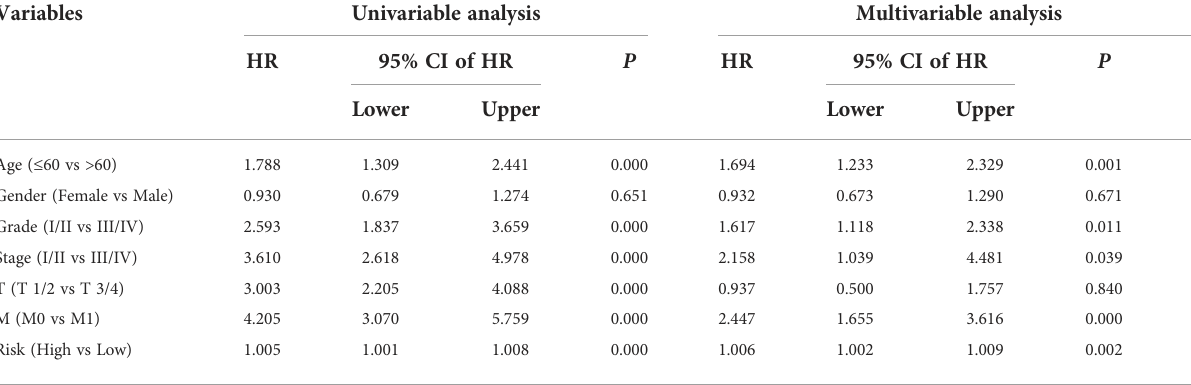
TABLE 2 Univariable and multivariable analysis of the HOX family gene-based signature and clinical factors in the TCGA cohort.